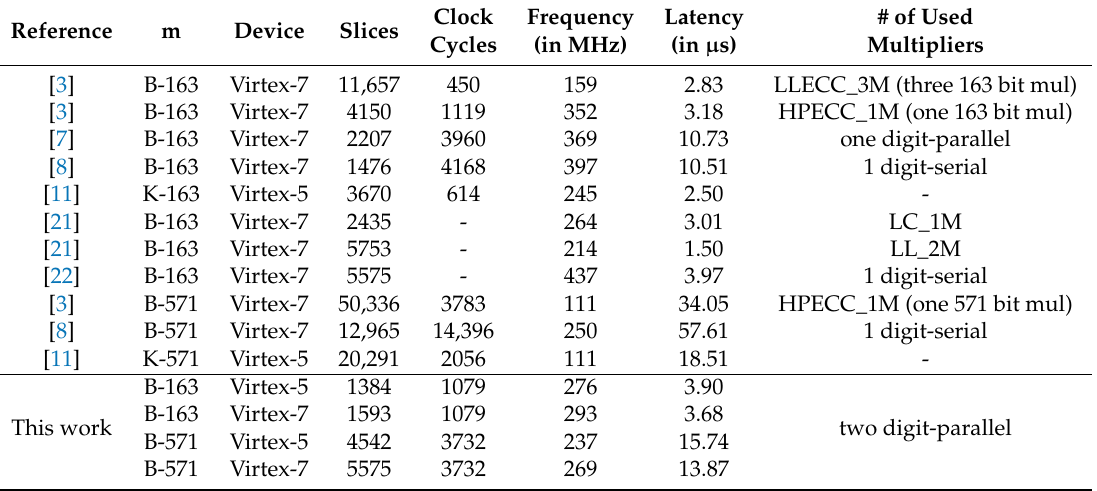
Table 2. Comparison with state-of-the-art over GF ( 2 163 ) and GF ( 2 571 ) on Xilinx FPGA devices.